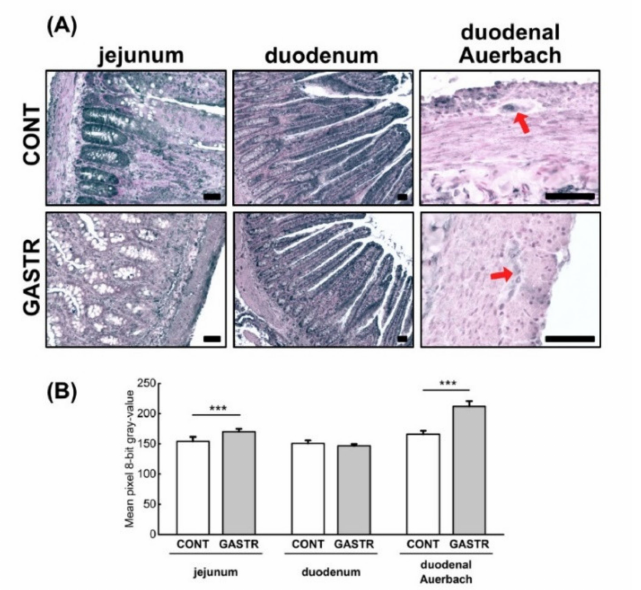
Figure 9. ( A ) Representative photomicrographs of the immunohistochemical reactions for ghrelin in the jejunum, duodenum and duodenal Auerbach plexus (red arrow). Sections developed in 3,3 (cid:48) -diaminobenzidine tetrahydrochloride with metal enhancer; counterstaining performed with Nuclear Fast Red. All the scale bars represent 100 µ m. ( B ) The intensity of expression of ghrelin, measured by the comparison of the pixel brightness values in the microscopic images converted to 8-bit grayscale. Scale from 0 (white pixel) to 255 (black pixel); the lower the pixel value, the higher the intensity of immunohistochemical reaction. Graph shows mean ± standard error. Significance was established using a two-tailed Student’s t -test (normally distributed data), Welch’s test (normally distributed data with unequal variances) or the Mann–Whitney test (for pairwise comparisons with at least one non-normally distributed dataset); *** p <